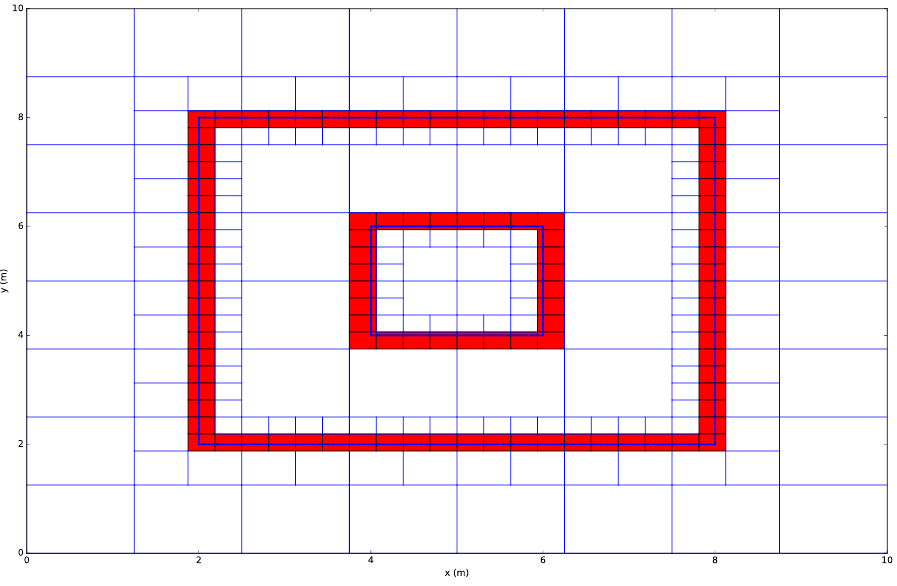
Figure 3. Example of a modeled environment in a Quadtree data structure. The red cell indicates the occupied cells.